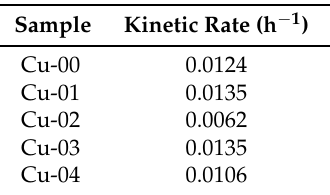
Table 4. Kinetic rate for Simazine decomposition catalyzed by ( a ) Cu-00; ( b ) Cu-01; ( c ) Cu-02; ( d ) Cu-03; and ( e ) Cu-04 samples under UV irradiation.